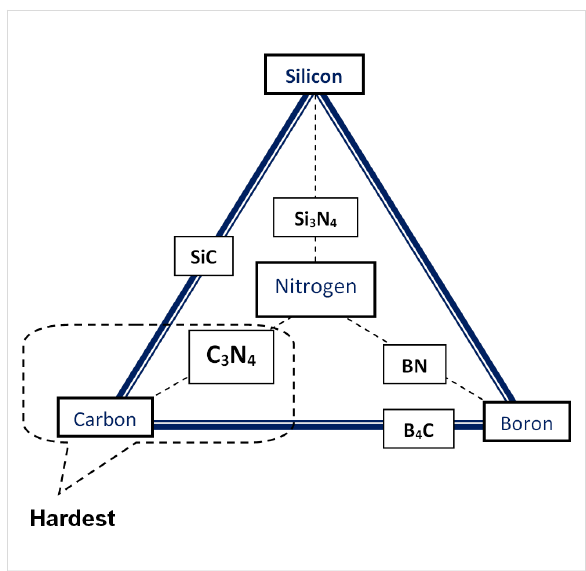
Figure 1: Composition cycle of ultra-hard materials (C–N–B–Si)